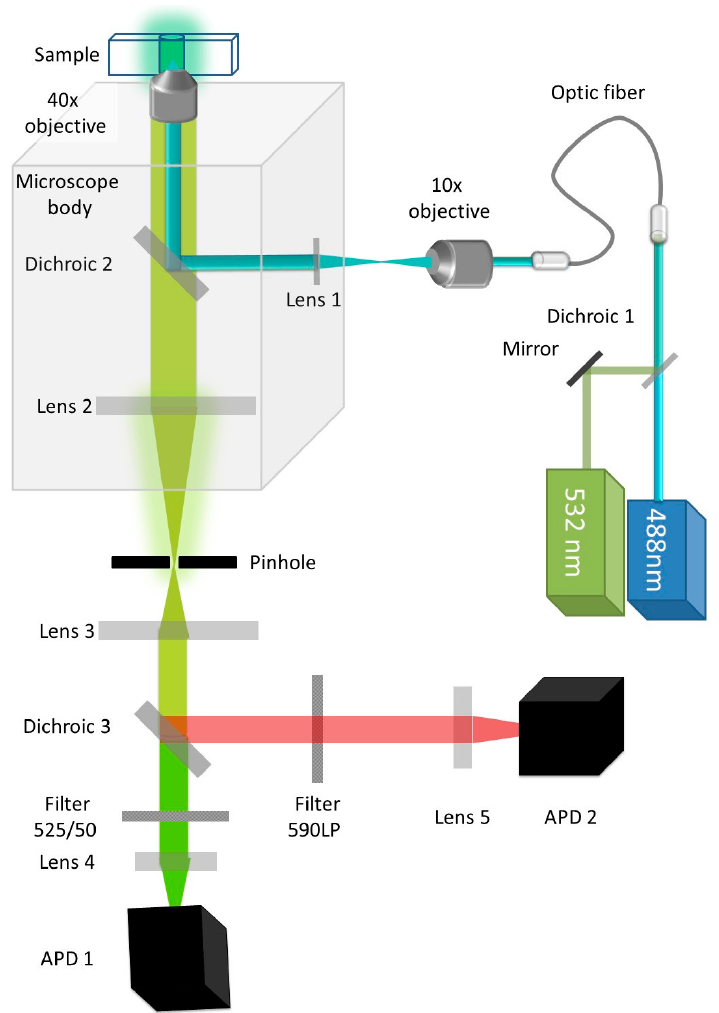
Figure 3. Schematic of the single molecule spectroscopy setup: In the brightness analysis mode, the 532 nm laser is turned off but this setup can also be used for single molecule coincidence or single molecule FRET. A 488 nm laser is used to illuminate the sample containing GFP. The light is focused and the resulting fluorescence is collected through a 40× magnification, 1.2 Numerical Aperture (NA) water immersion objective. In the dual color mode, the fluorescence from GFP and Cherry is separated by a dichroic filter. Fluorescence from GFP is filtered by a 505–540 band pass filter. The number of photons collected in 1 ms time bins is recorded as IGFP (t). Avalanche Photo Diodes (APDs) are used for photon counting.